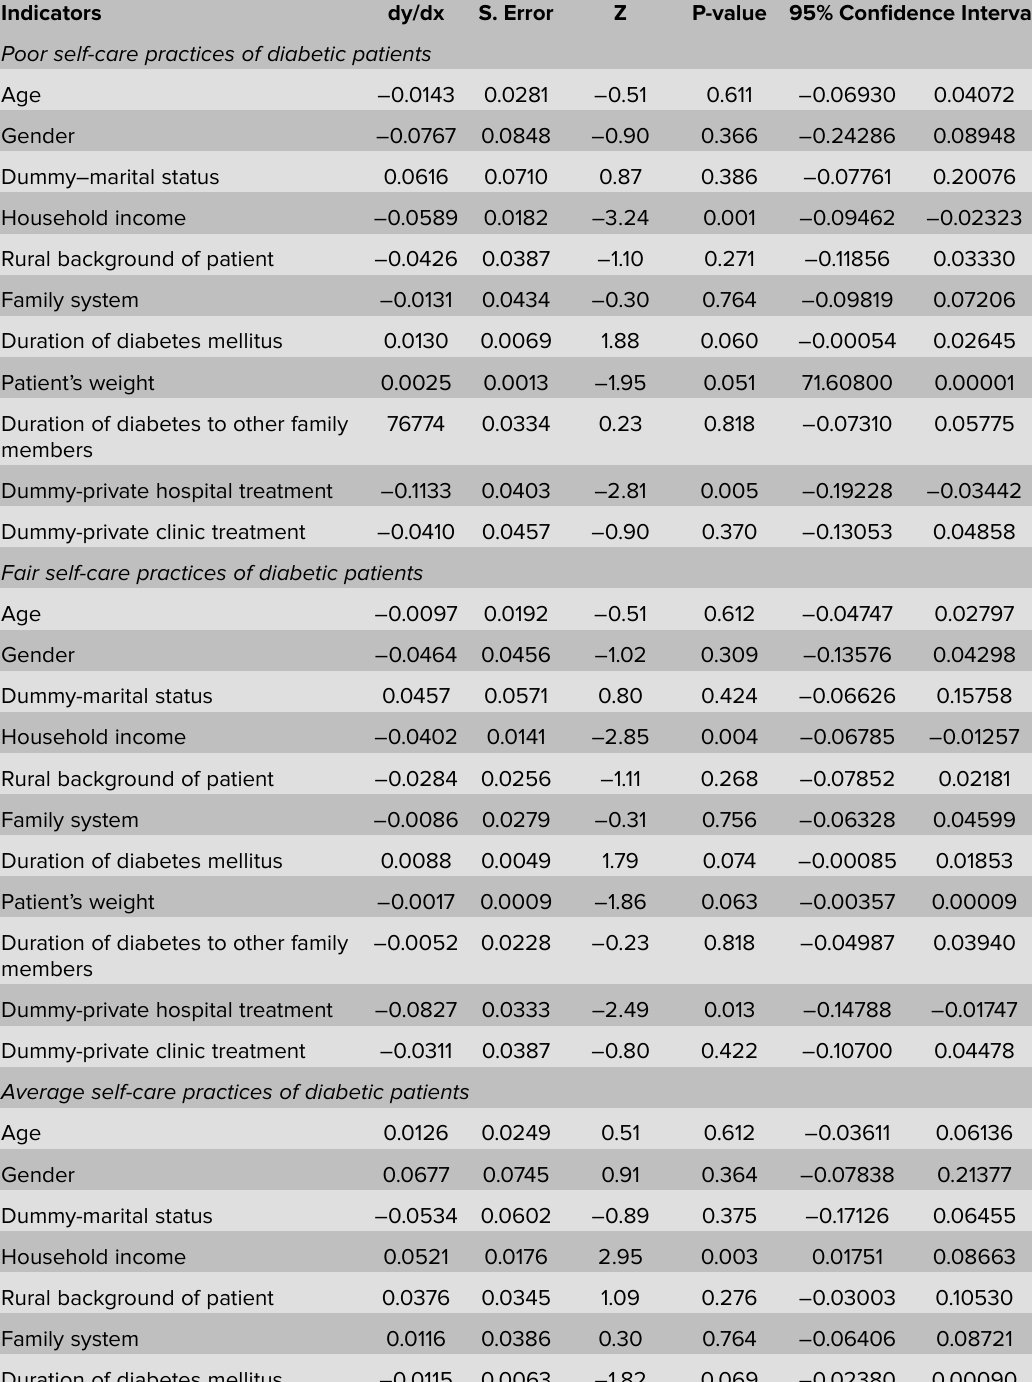
Table 3: Marginal effects of predictors on different self-care practices of diabetic patients [ N =